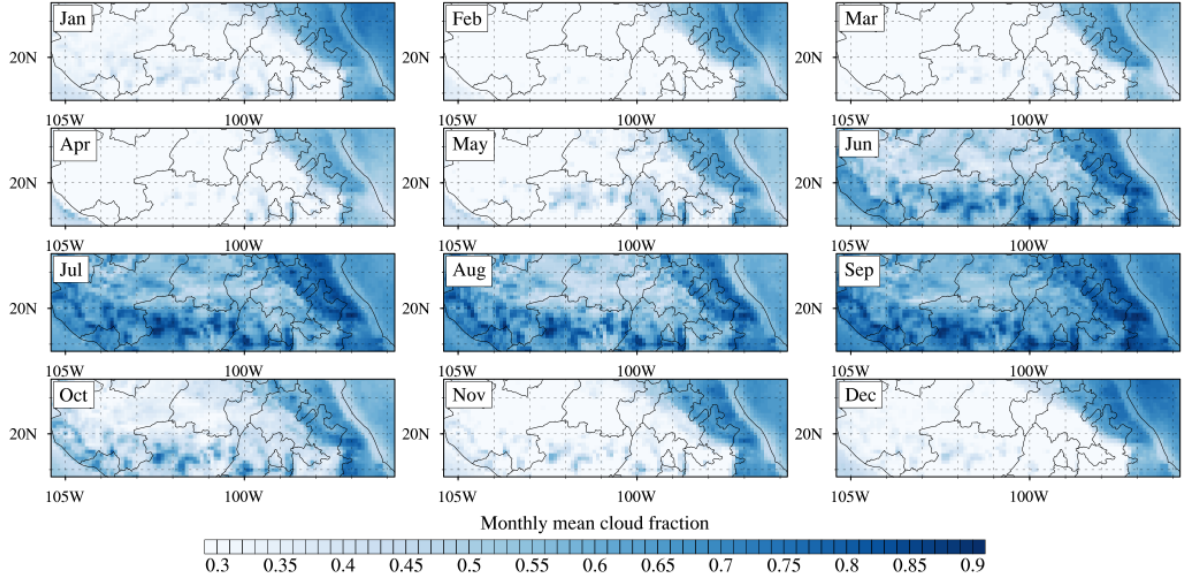
Figure 2. Monthly distribution of mean cloud fraction based on Moderate-Resolution Imaging Spectroradiometer (MODIS) cloud data (2008–2017) with a horizontal resolution of 0.1